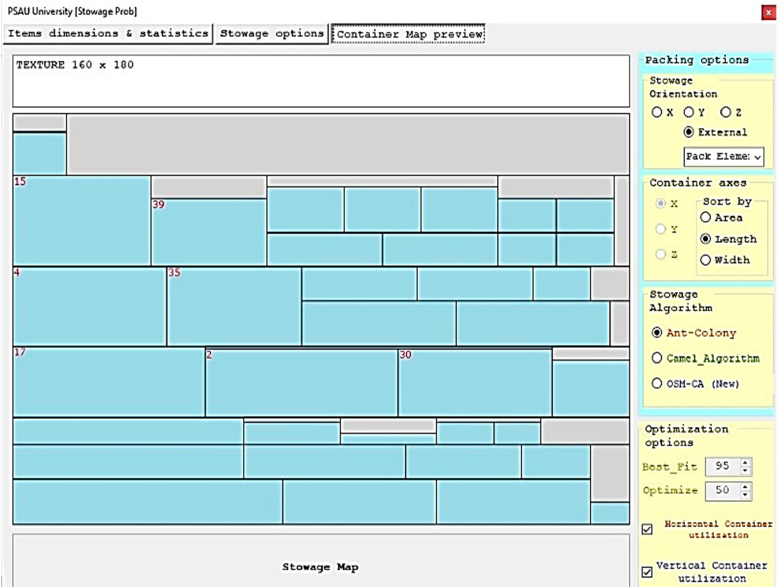
Processes 2022 , 10 , x FOR PEER REVIEW Figure A11. The stowage map by ant-colony algorithm for third station on the distribution path.